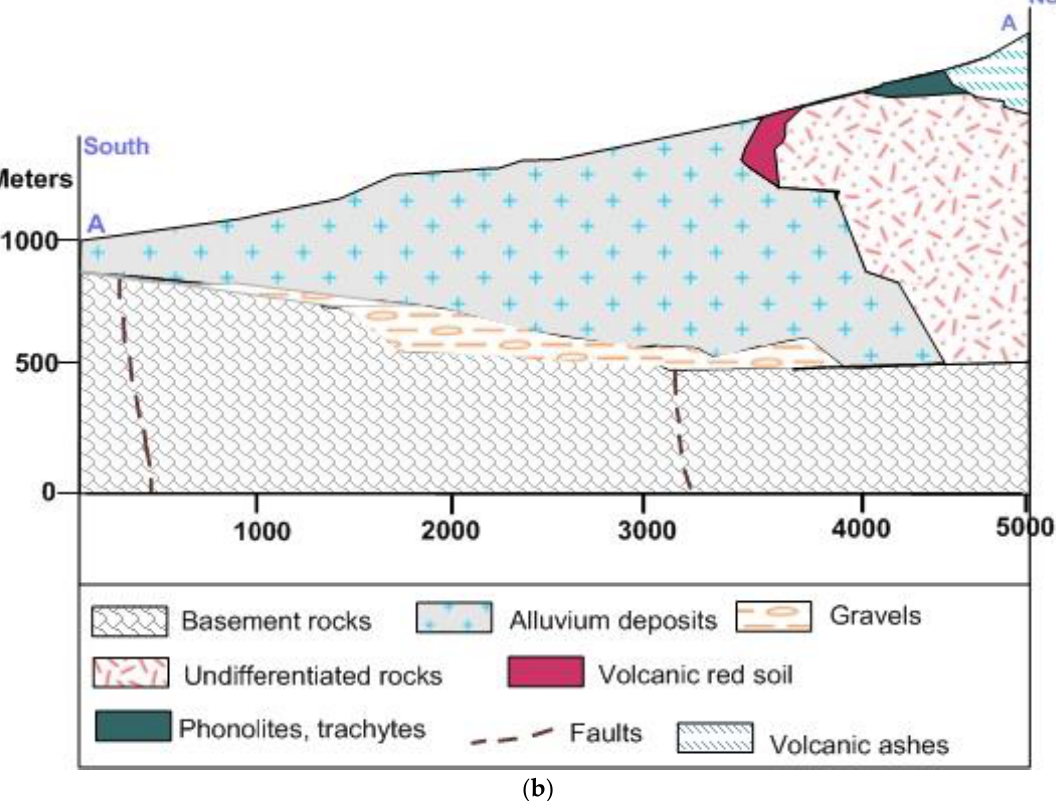
Figure 2. ( a ) Hydrogeological map of Kahe Catchment; ( b ) hydrogeological cross-section A–A along the north–south direction.